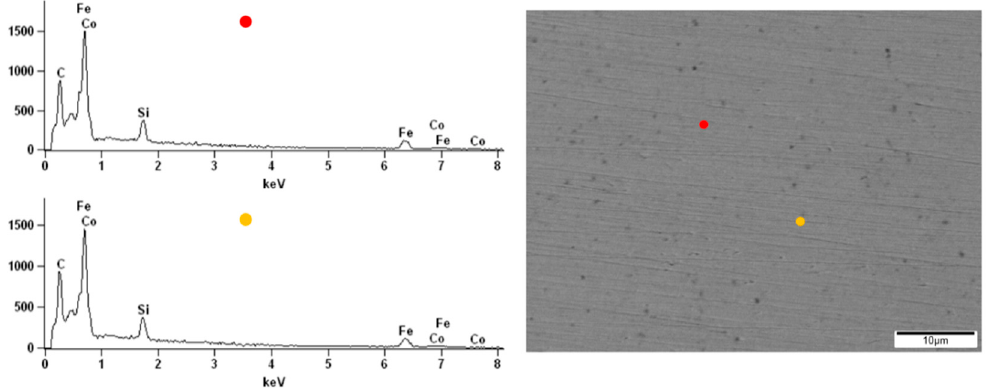
Figure 10. The SEM micrographs of the surface and spectrums of the point EDX analysis for the Fe 62 Co 15 B 14 Si 9 alloy.